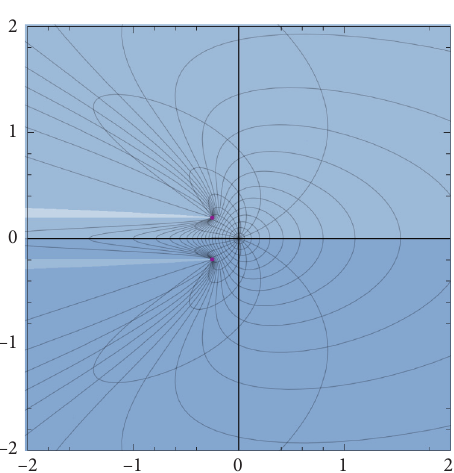
Figure 5: Image of P